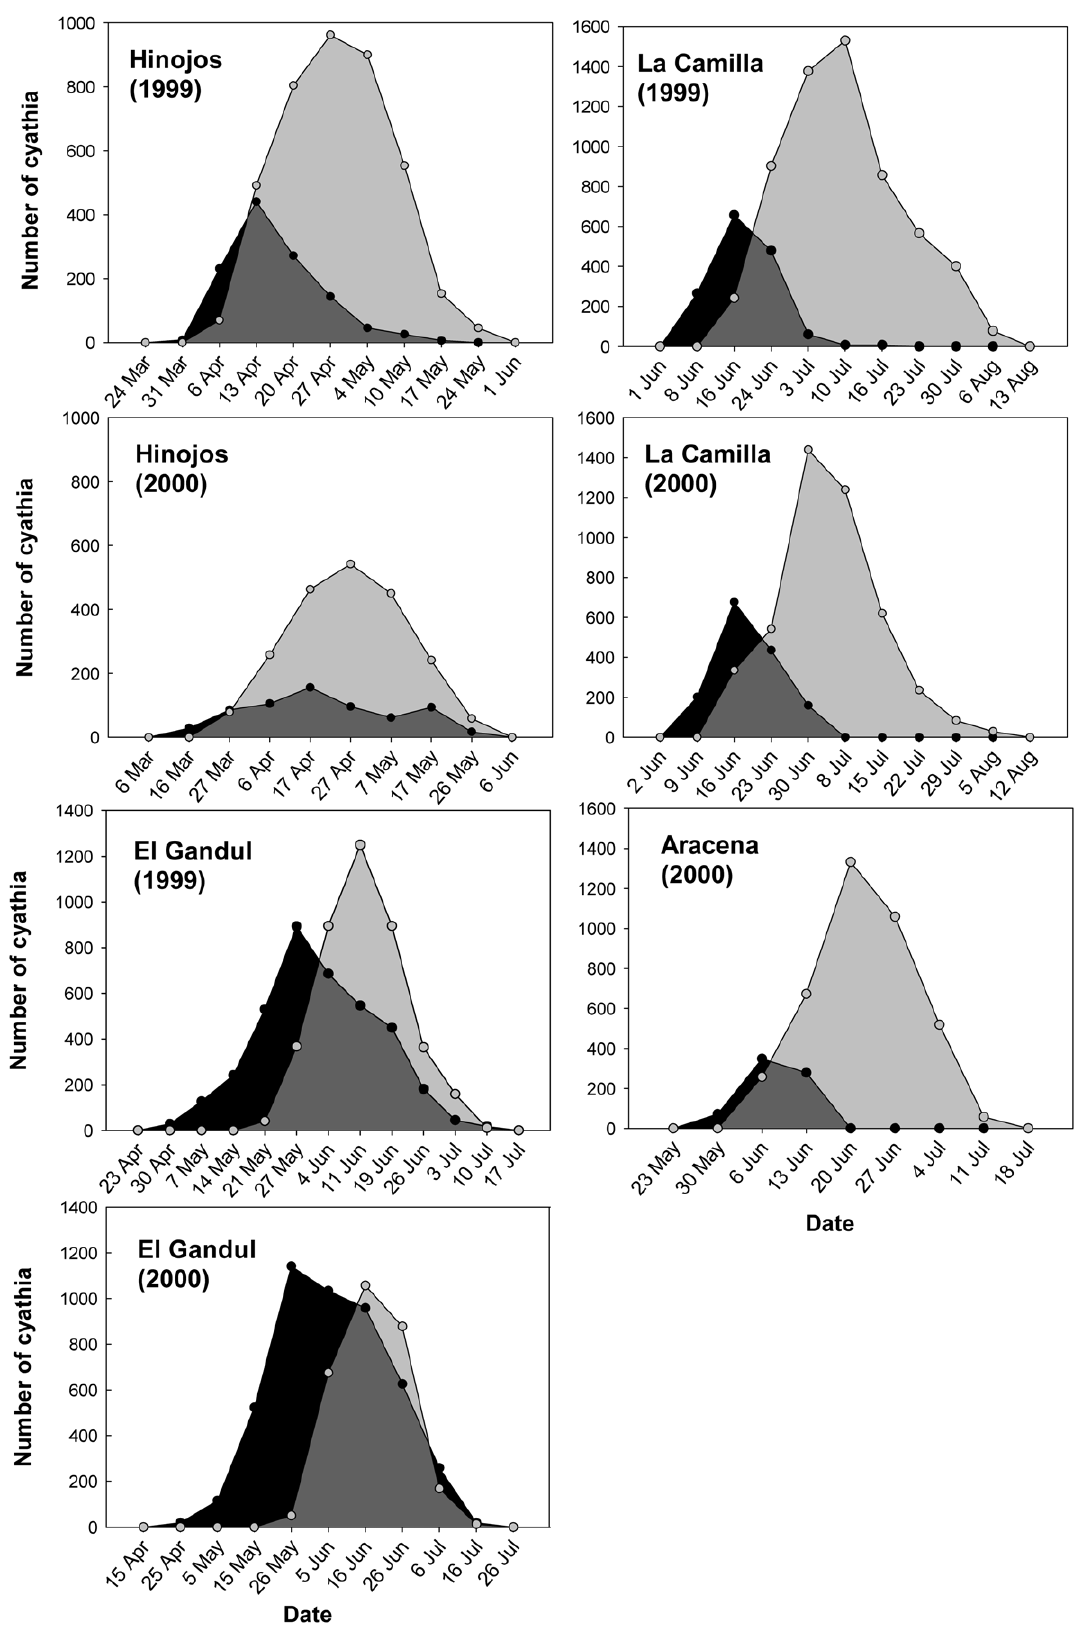
Figure 2. Flowering phenology of male (black circles) and hermaphrodites (gray circles) of E. boetica (left) and E. nicaeensis (right) in four populations over two years. Each point represents the mean of the population on the census date. doi:10.1371/journal.pone.0020668.g002 PLoS ONE |